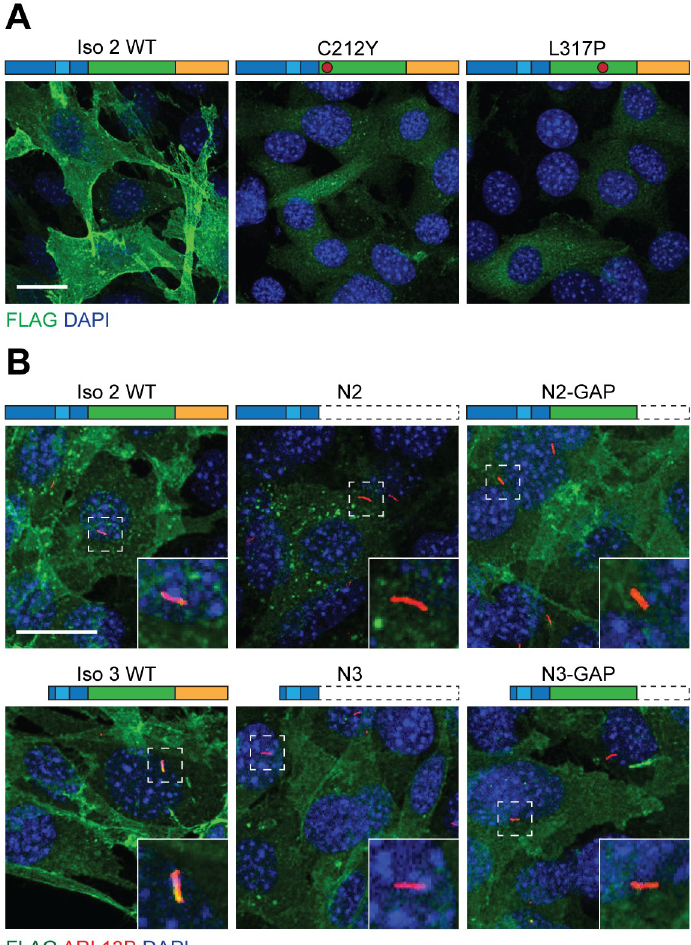
Fig 4. The GAP-like and C-terminal domains regulate ARHGAP36 localization. Subcellular distributions of the indicated FLAG-tagged ARHGAP36 point mutants (A) and truncation mutants (B) in NIH-3T3 cells. Representative maximum-intensity Z-stack projections are shown with immunofluorescent staining for FLAG and DAPI (nucleus) (A) or FLAG, DAPI, and ARL13B (primary cilium) (B). Insets highlight ciliated regions in the dashed boxes. Scale bar: 20 μ m. Images were processed to establish comparable maximum pixel intensities in order to highlight differences in